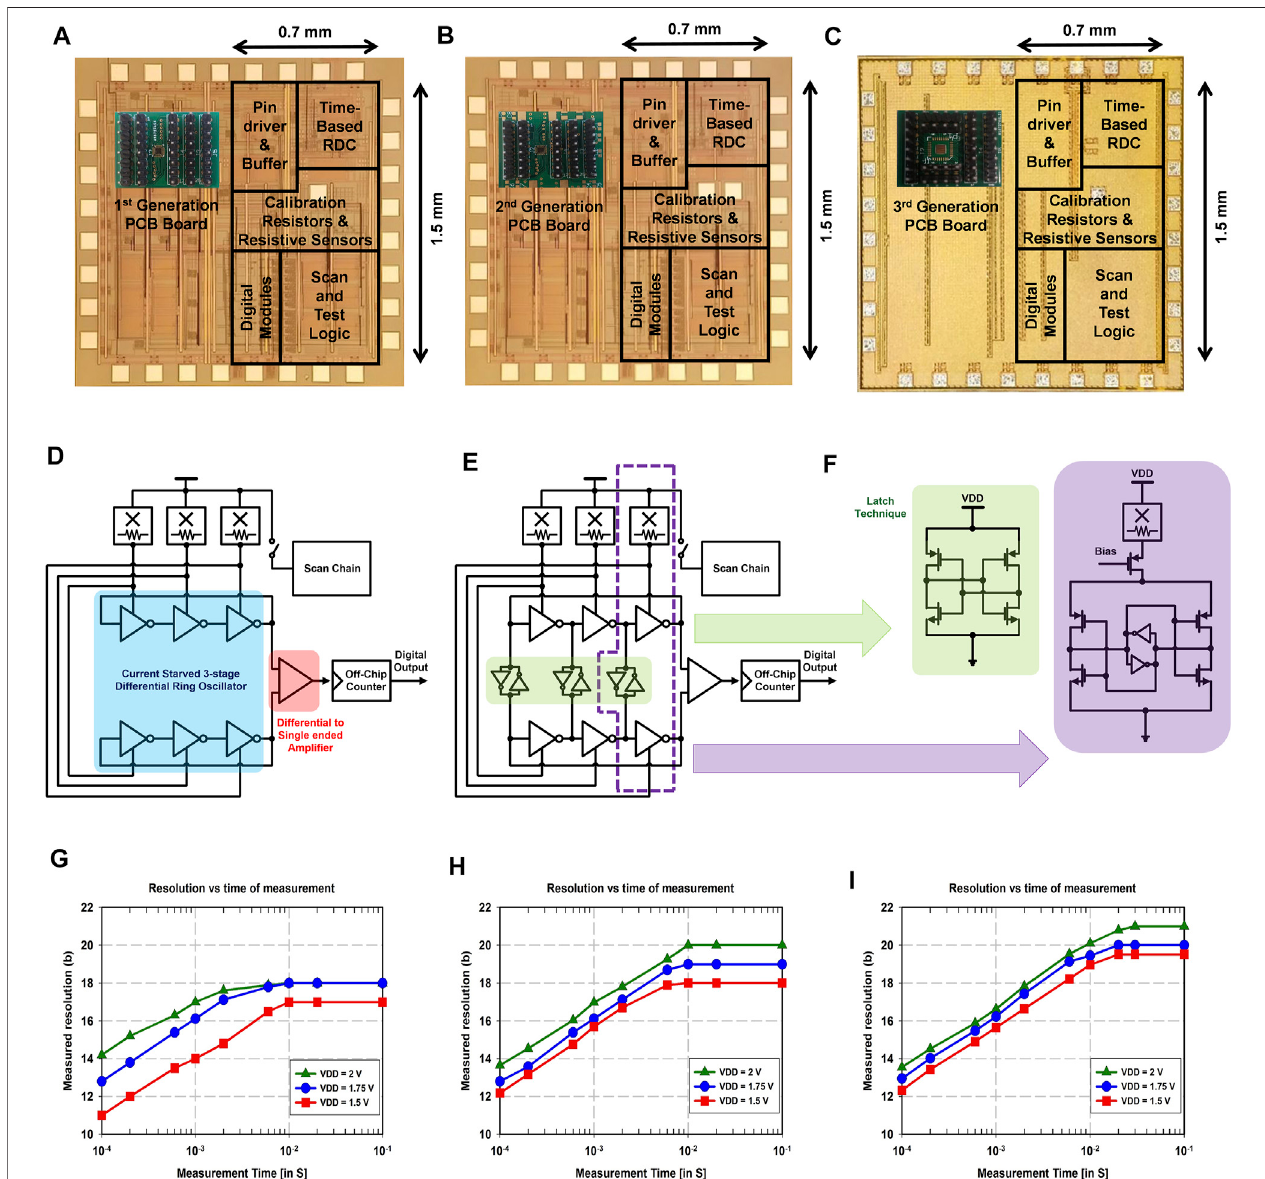
FIGURE12|(A) Chipmicrographofthe0.35- μ mtime-basedRDC(design1), (B) chipmicrographofthe0.35- μ mtime-basedRDCwiththespeed-uplatch(design 2), (C) chip micrograph of the 0.18- μ m time-Based RDC with the speed-up latch (design 3), (D) circuit diagram of 0.35- μ m time-based RDC, (E) circuit diagram of the 0.35- μ m and 0.18- μ m time-based RDC with the speed-up latch, (F) detailed circuit schematic consisting of the speed-up latch technique, (G) resolution vs. time of measurementofthe0.35- μ mtime-basedRDC(design1), (H) resolutionvs.timeofmeasurementofthe0.35- μ mtime-basedRDCwiththespeed-uplatch(design 2), and (I) resolution vs. time of measurement of the 0.18- μ m time-based RDC with the speed-up latch (design 3).